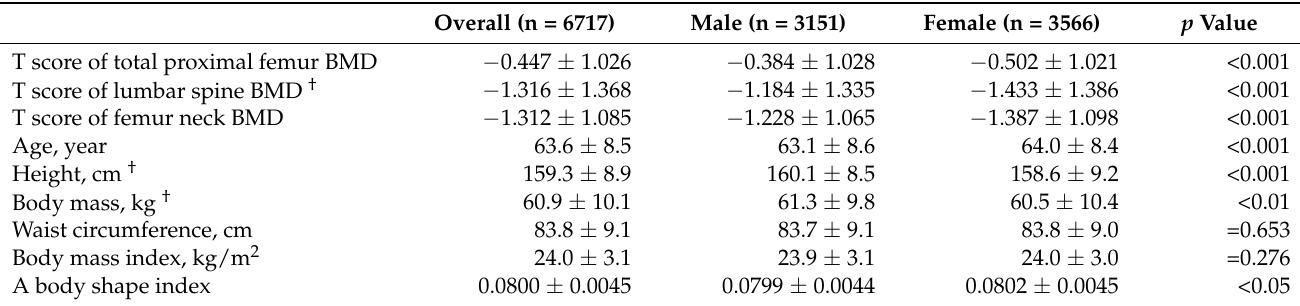
Table 1. Characteristics of the study